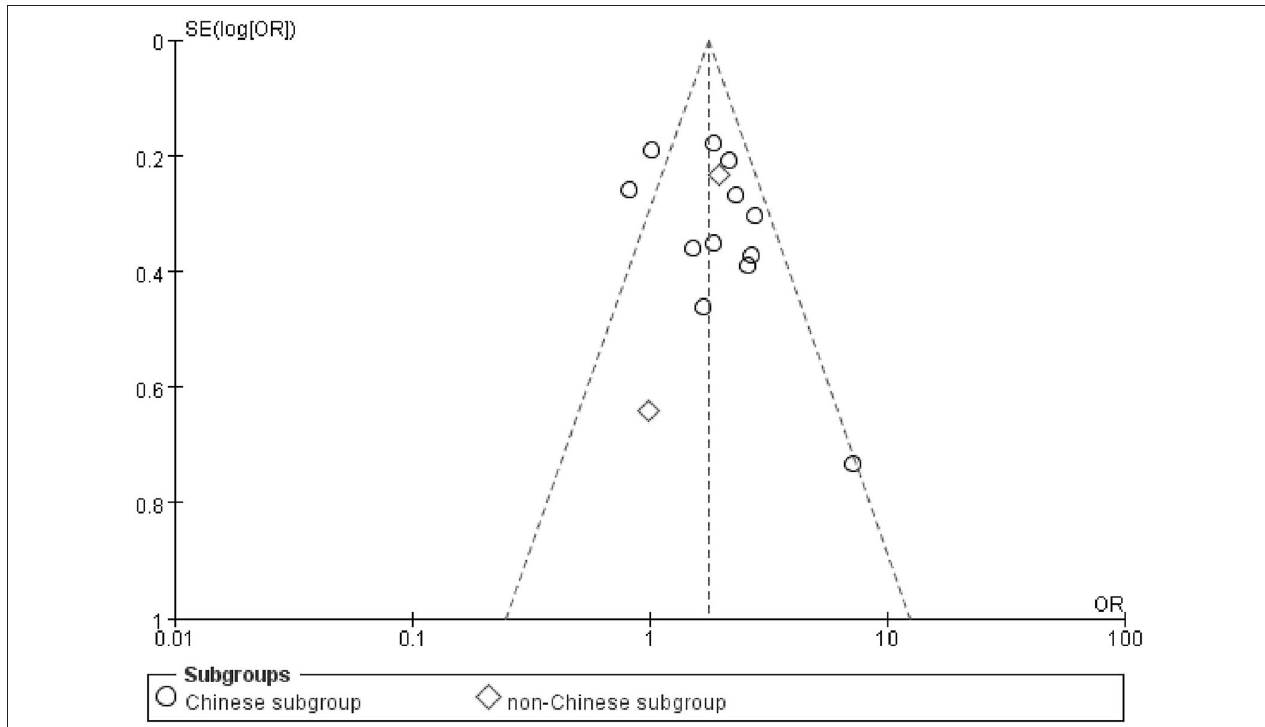
FIGURE 5 | The funnel plot for studies of the association of CAD and PCSK9 gene E670G polymorphism under an allelic genetic model (distribution of G allele frequency of PCSK9 gene E670G polymorphism). The horizontal and vertical axis correspond to the OR and confidence limits. OR, odds ratio; SE, standard error.